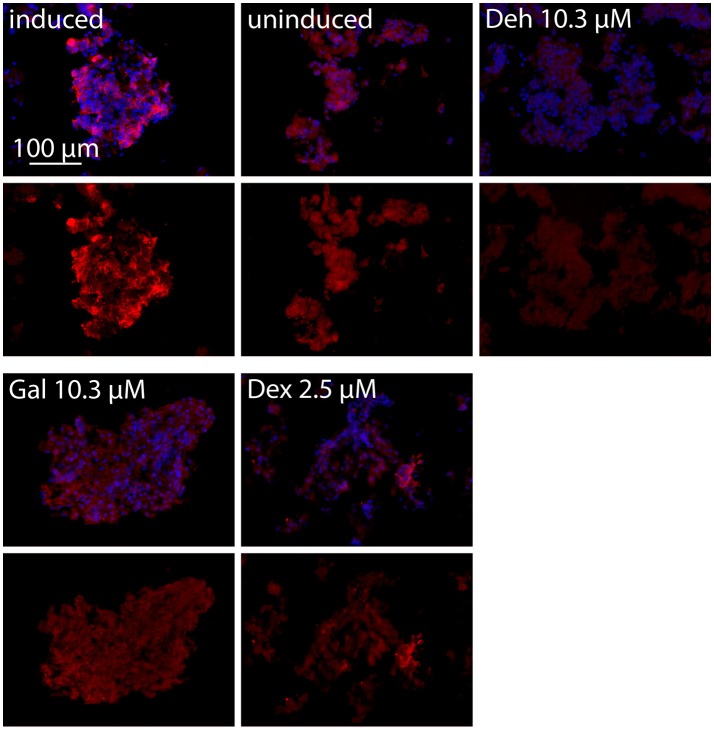
iNOS immunofluorescence staining of adult ENS networks after anti-inflammatory treatment. Cells were pretreated for 1 h with the indicated concentrations of test compounds prior to stimulation with CM for 24 h. iNOS positive cells (red, iNOS) and nuclei (blue, DAPI). Merge image (upper row), iNOS (lower row). Induced, cytokine induced culture; uninduced, uninduced control culture; Deh 10.3 μM, dehydrocurvularin 10.3 μM; Gal 10.3 μM, galiellalactone 10.3 μM; Dex 2.5 μM, dexamethasone 2.5 μM.